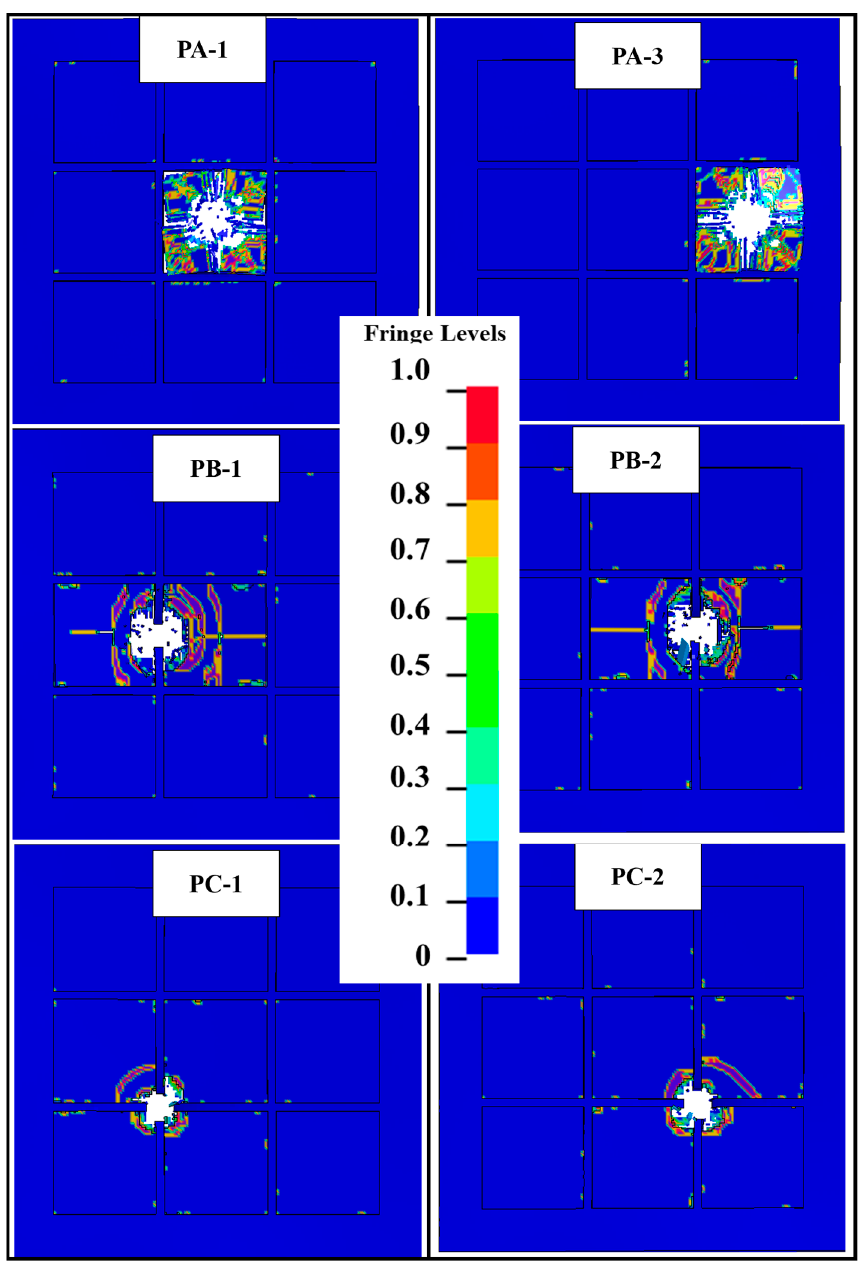
Figure 20. Damage of ceramic material of PA, PB, and PC after impact. The deformation of the UHMWPE laminate on the back of the protective structure when the projectile hits different points is shown in Figure 21. The deformation range and ridge height of the UHMWPE laminate in PA-2 are smaller than those of PA-1 and PA-3. The deformation range of the UHMWPE laminate in PA-2 is larger than that in PA-1. This is mainly because the asymmetric target frame constraints make the deformation of the UHMWPE laminate in the positive and negative directions of the Y axis and the negative direction of the X axis constrained. Therefore, these reasons lead to the range of defor- mation asymmetry.